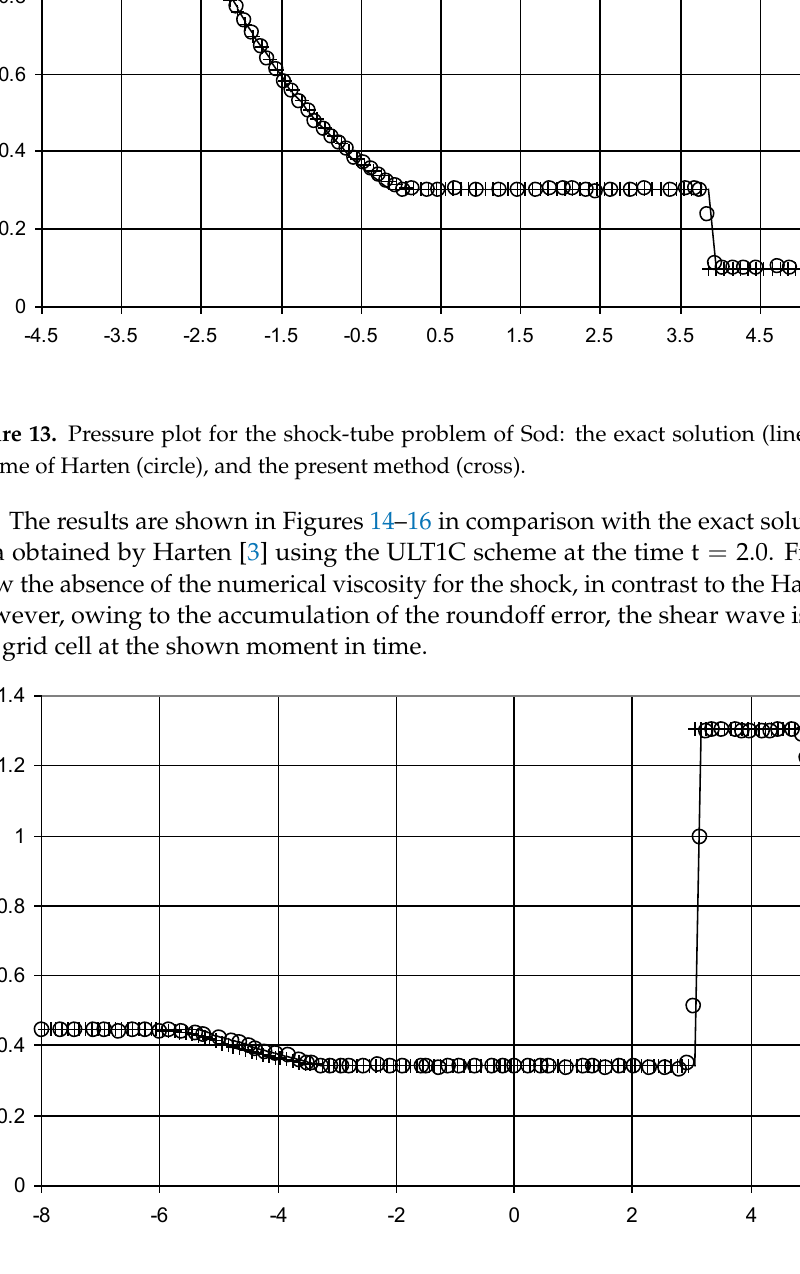
Figure 14. Density plot for the Riemann problem of Lax: the exact solution (line), the ULT1C scheme of Harten (circle), and the present method (cross).